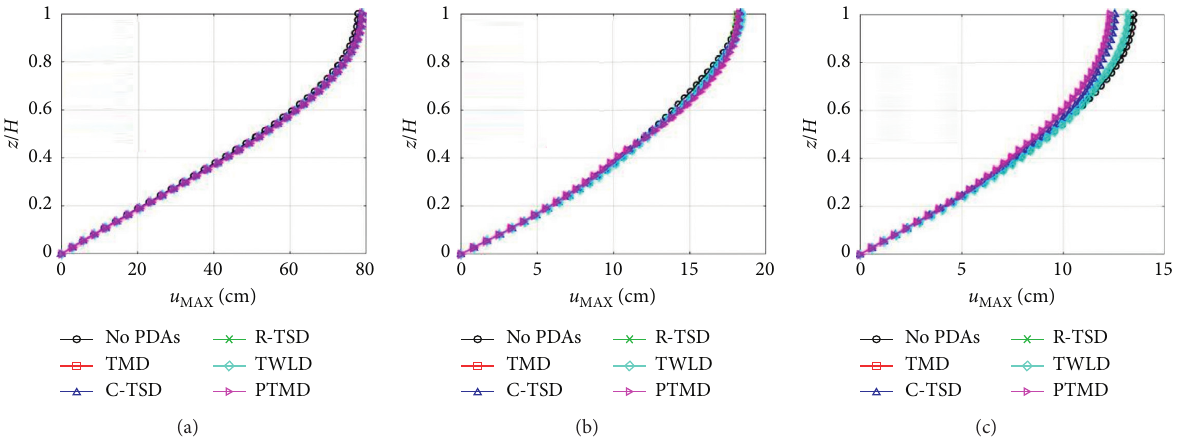
Figure 11: Seismic peak displacements of the building: xz plane. (a) CDAF. (b) SXVI. (c) CUMV.